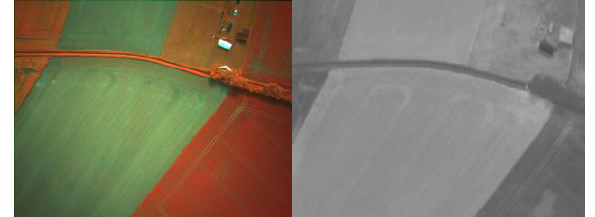
Figure 13. In-Flight Multispectral and Thermal